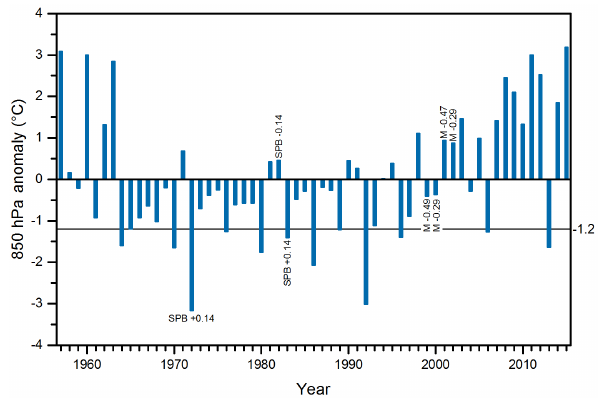
Figure 5. Temperature anomalies at the 850hPa level ( ◦ C) over the period 1957–2016 (referenced to the period 1981–2010) from the Alert radiosonde record. The horizontal black line shows the es- timated summer average Arctic temperature anomaly for the LIA relative to 1981–2010 ( − 1 . 2 ◦ C). Also shown are the annual mass balance estimates for the larger St. Patrick Bay (SBP) ice caps for the 1981/1982 and 1982/1983 balance years and for the Murray Ice Cap (M) for the 1999/2000, 2000/2001, 2001/2002, and 2002/2003 balance years (in